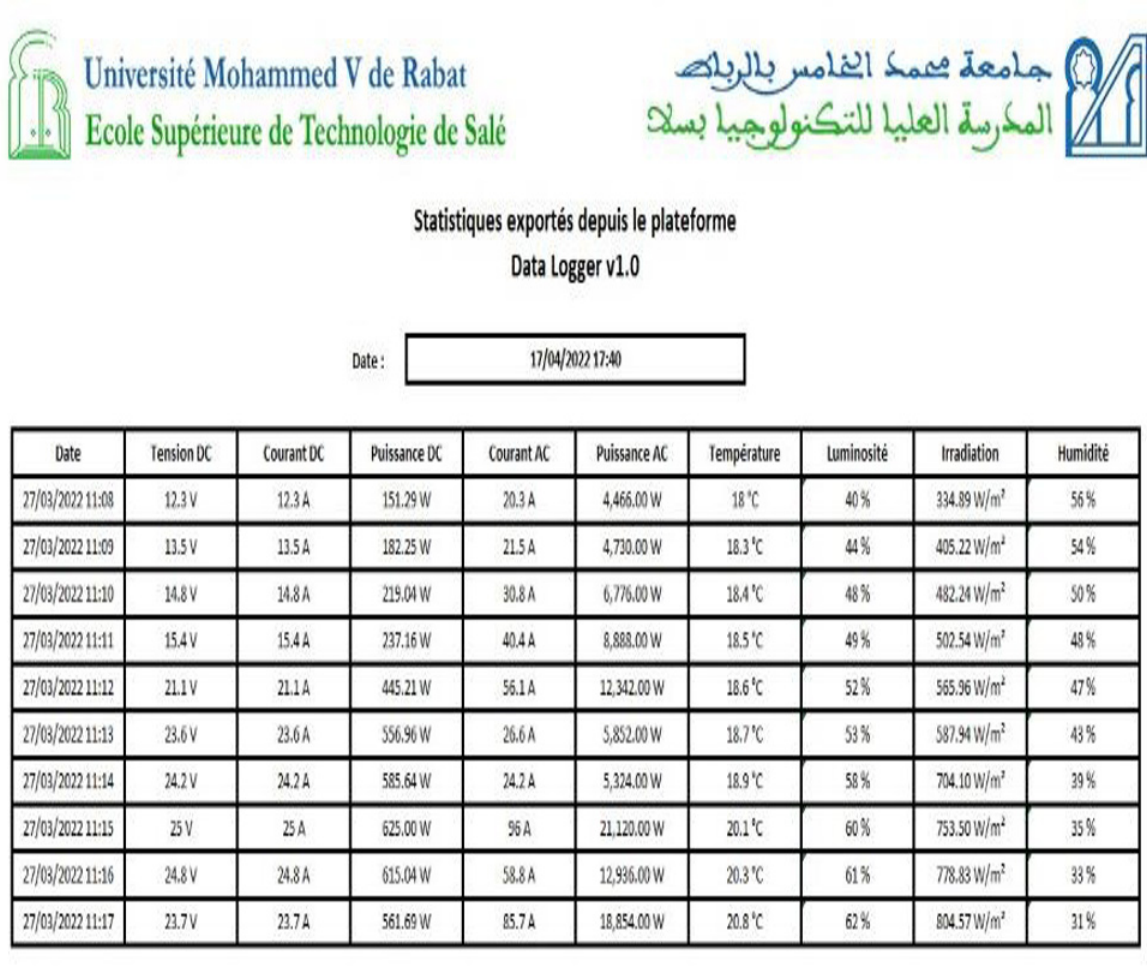
Fig. 10 exported file in excel